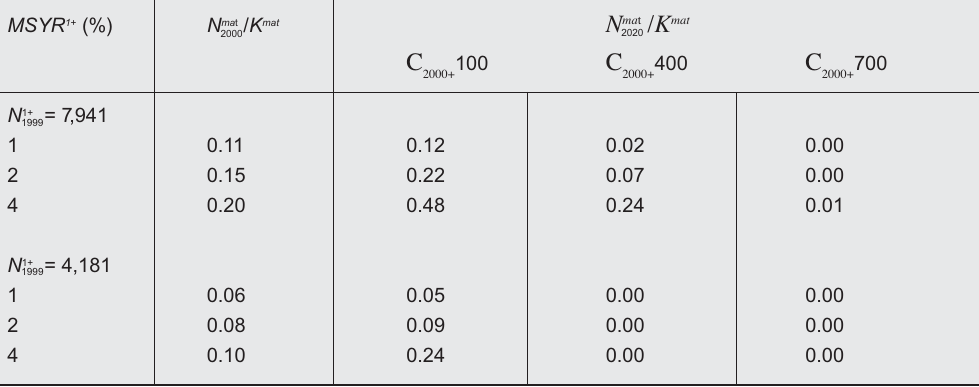
) of 100, 400 and 700 animals 2000+